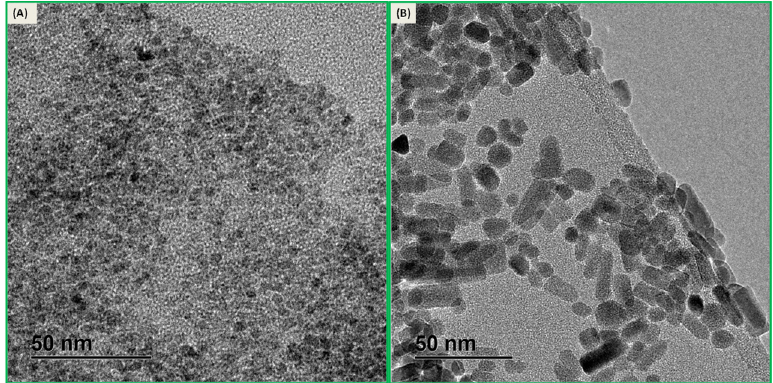
Figure 2. TEM images for ( A ) un-doped and ( B ) (0.5 mol%) Ho 3+ -doped ZnO nanocrystals. Figure 3 illustrates the X-ray diffraction (XRD) profiles of the ZnO and ZnO:Ho 3+ nanocrystals. The analysis revealed that the as-synthesized nanocrystals ranging between 4–8 nm in diameter (See Table 1) were highly crystalline and exhibited the hexagonal wurtzite structure (space group P 6 3 mc ) indexed to JCPDS card # 36-1451. Furthermore, no second phase originating from Ho 2 O 3 was observed in the Ho 3+ -doped ZnO samples